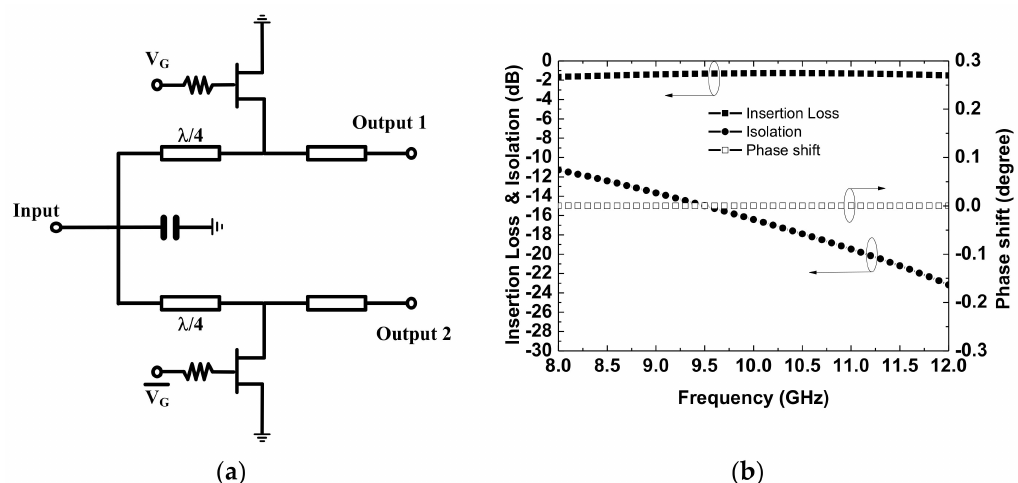
Figure 3. ( a ) Schematic of the shunt single-pole/double-throw (SPDT) switch; ( b ) simulated insertion loss, isolation, and phase shift between on and off states of the shunt SPDT